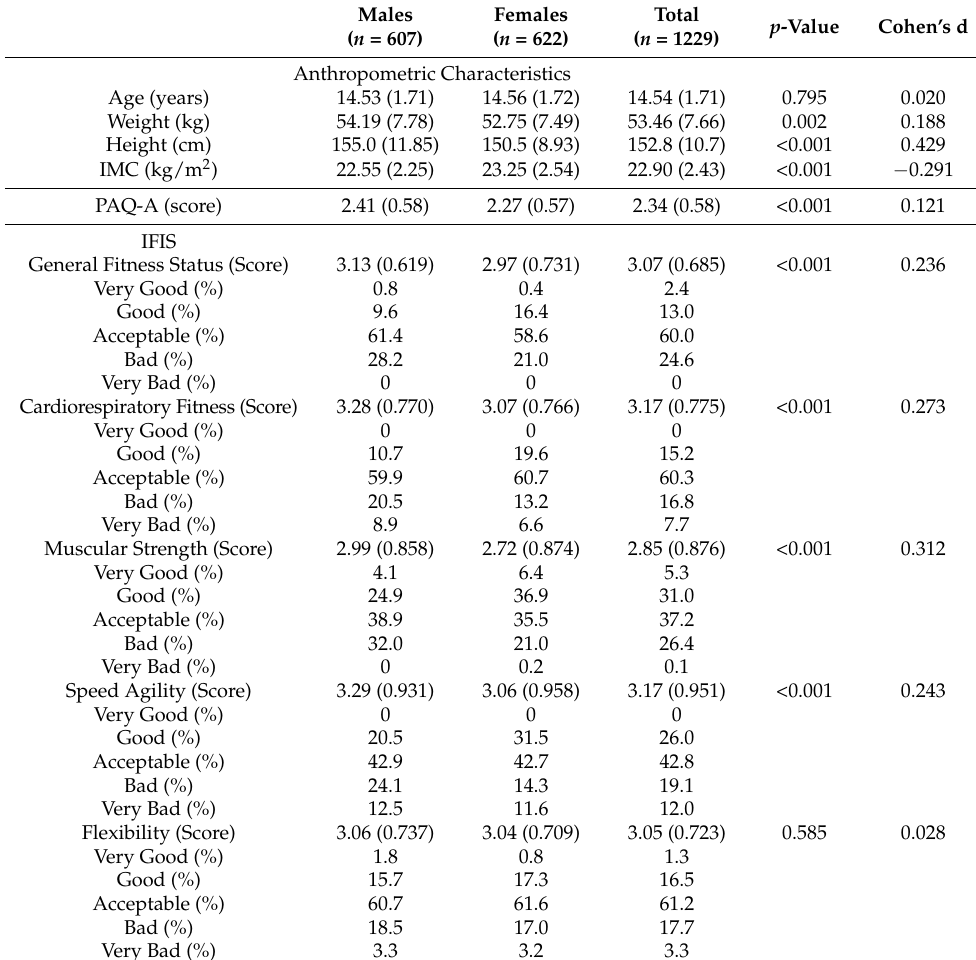
Table 1. Socio-demographic comparison of